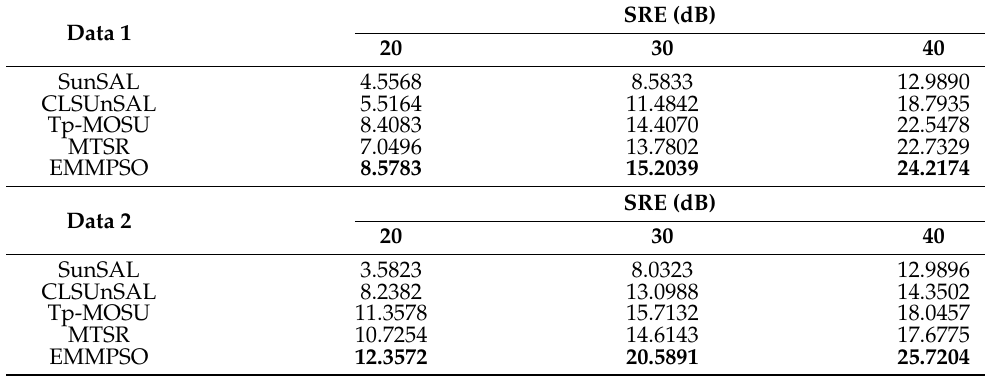
Figure 8. The fractional abundance maps of endmember 1, 3, 5 by SunSAL, CLSUnSAL, Tp-MOSU, MTSR and EMMPSO on Data 2. Table 2. Comparison of EMMPSO and other methods on data 1 and data